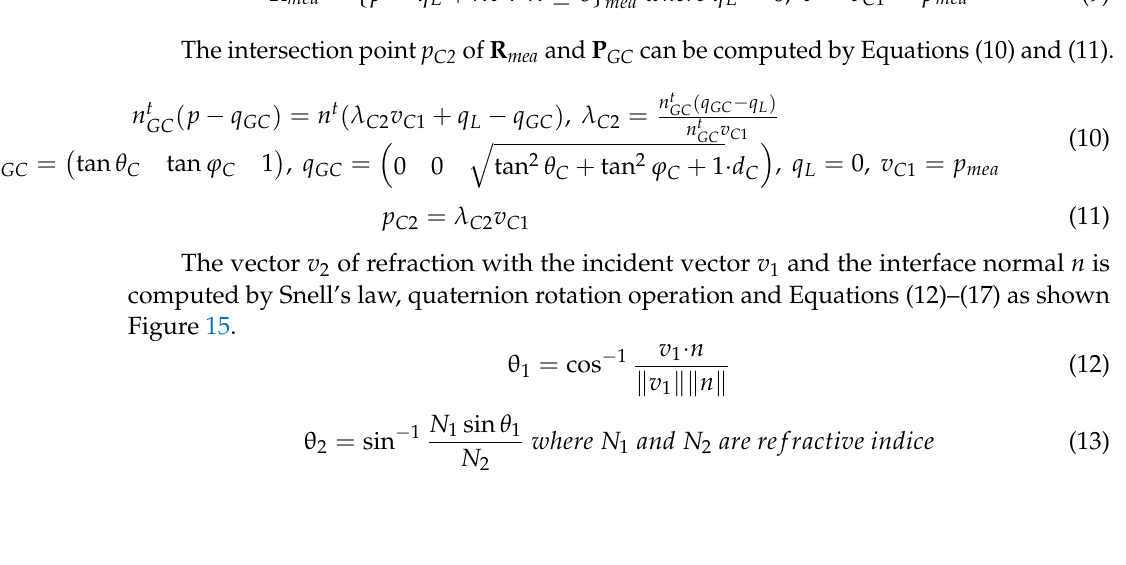
Figure 14. Plane Model.